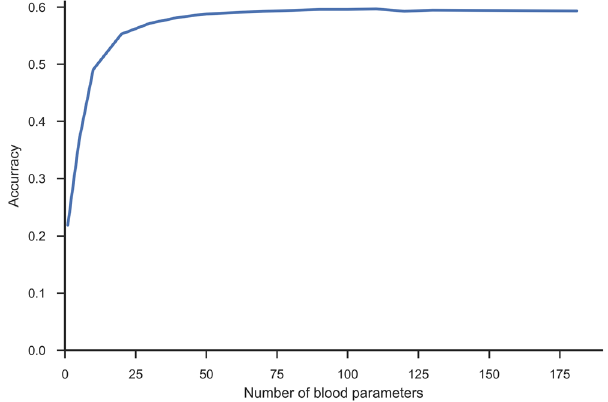
Figure 4. Learning curve. Learning curve with increasing numbers of parameters, ordered by their importance according to ReliefF